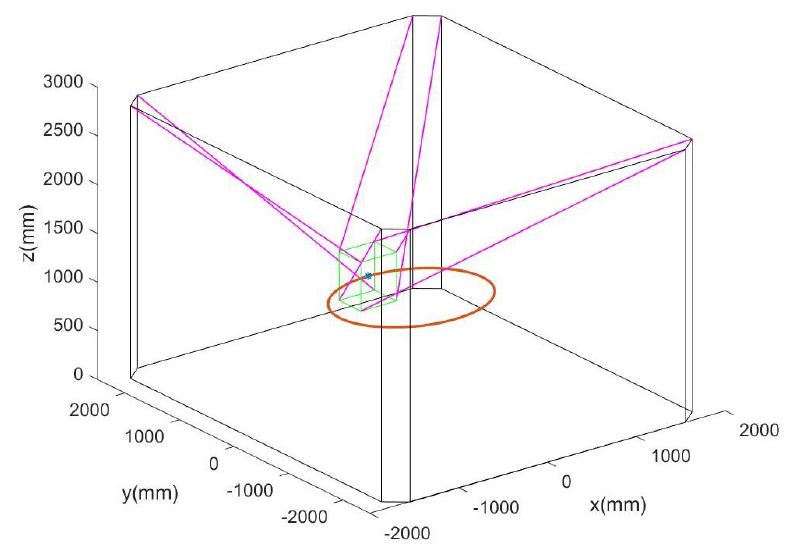
Figure 7. Circle trajectory of r = 800 (mm).